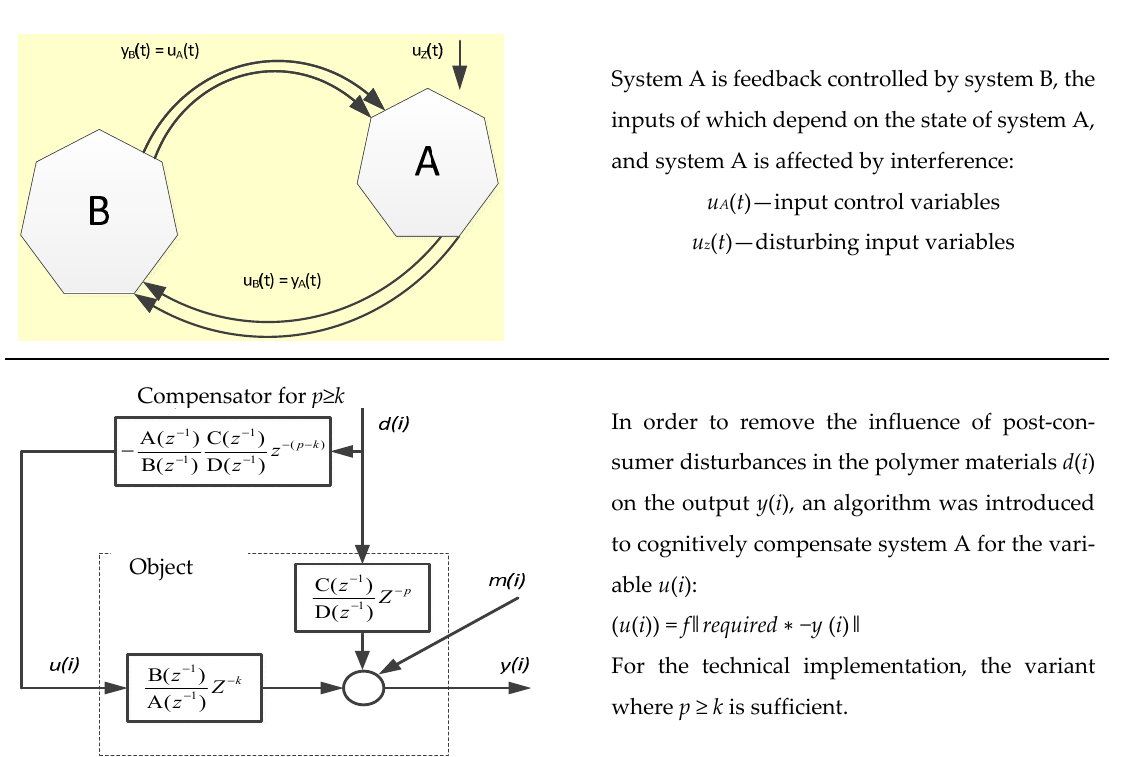
Figure 3. Control, regulation, and compensation of interference of polymer materials resulting from operation. Own work based on data from [70–72].